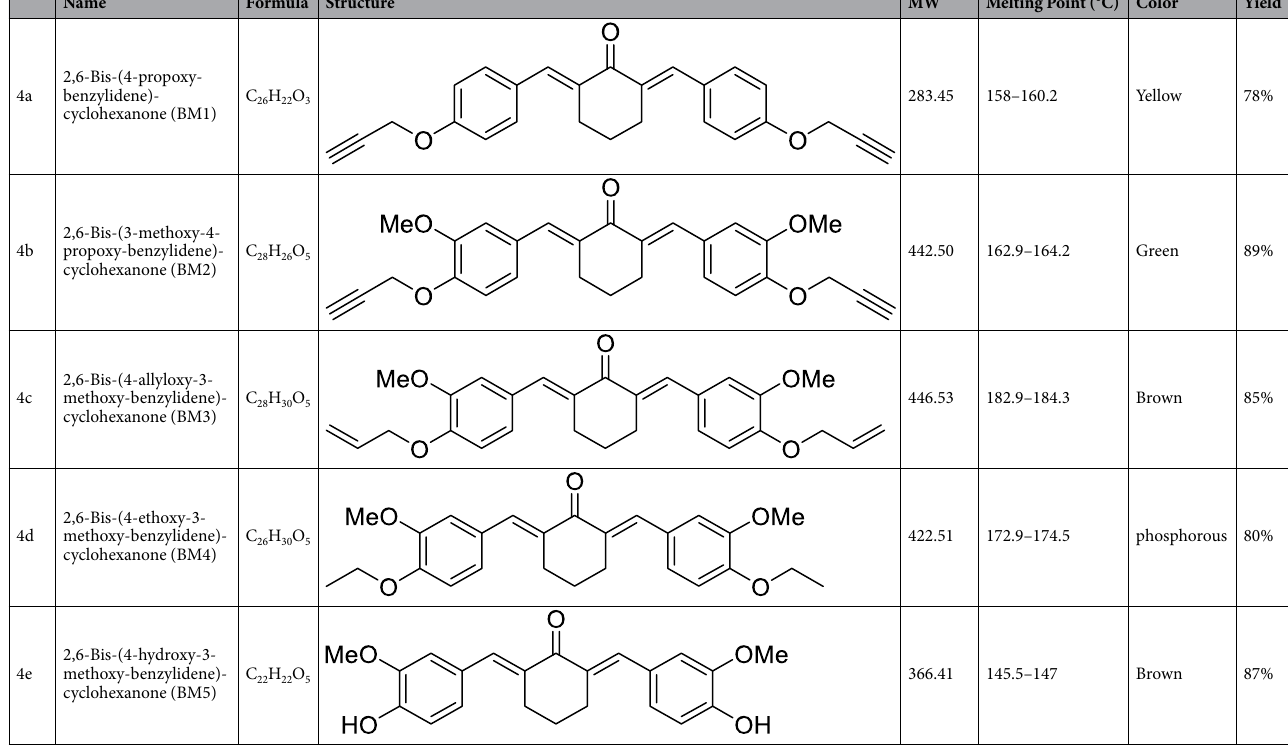
Table 1. Chemical characterization of the synthesized 2,6-bis benzylidene cyclohexanones including formula, structure, molecular weight, melting point, color and yield.